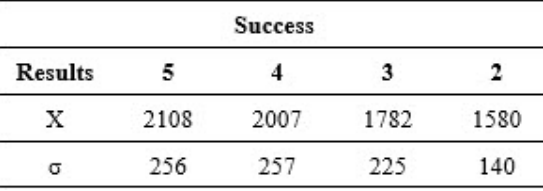
Table 2. Results (X and σ) by the suc -